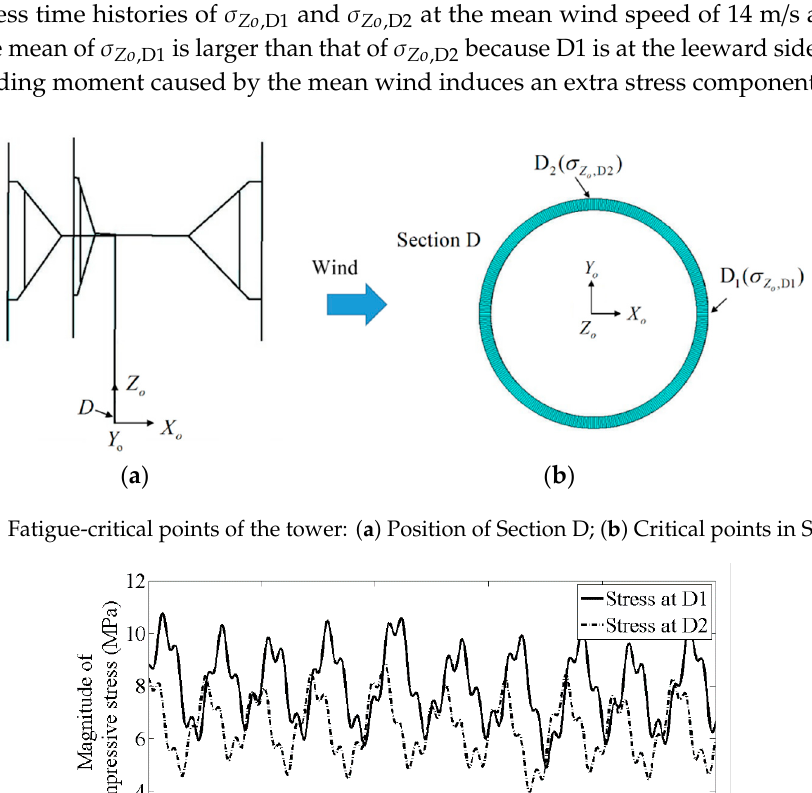
Figure 14. The mean of σ Zo ,D1 is larger than that of σ Zo ,D2 because D1 is at the leeward side of the tower. Thus, the bending moment caused by the mean wind induces an extra stress component at point D1.